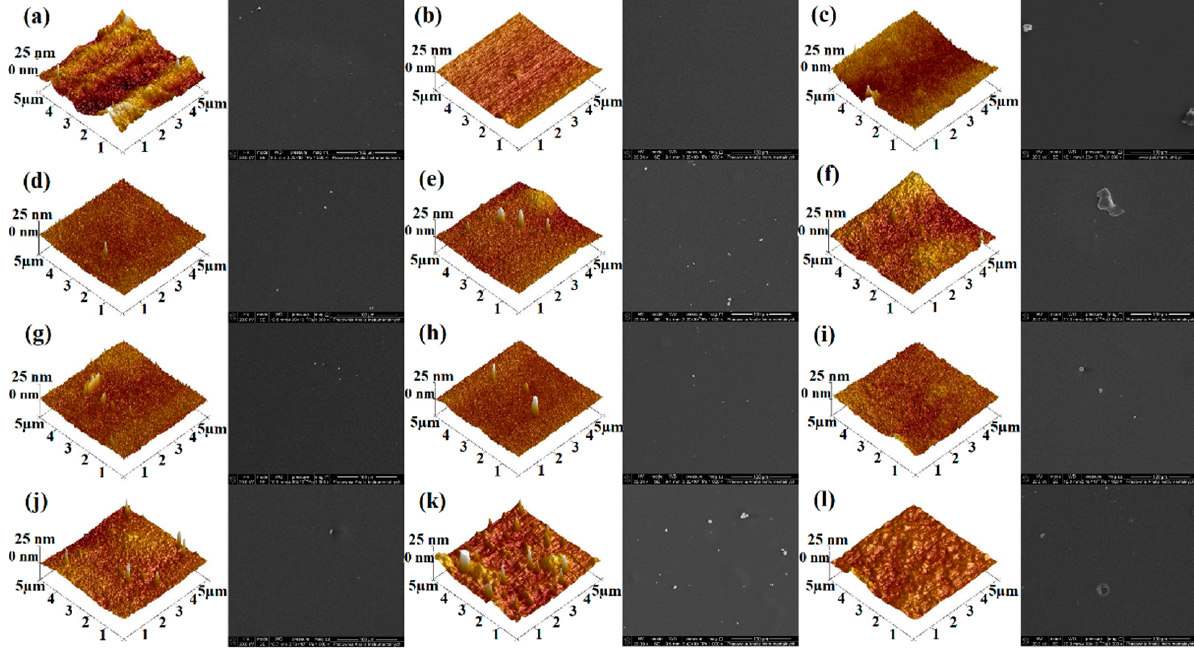
Figure 6. AFM and SEM (1000×) images of ( a ) chitosan films cross-linked by ( d ) 5% NDASs, ( g ) 10% NDASs, and ( j ) 15% NDASs; ( b ) gelatin film cross-linked by ( e ) 5% NDASs, ( h ) 10% NDASs, and ( k ) 15% NDASs; and ( c ) chitosan–gelatin films cross-linked by ( f ) 5% NDASs, ( i ) 10% NDASs, and ( l ) 15% NDASs.